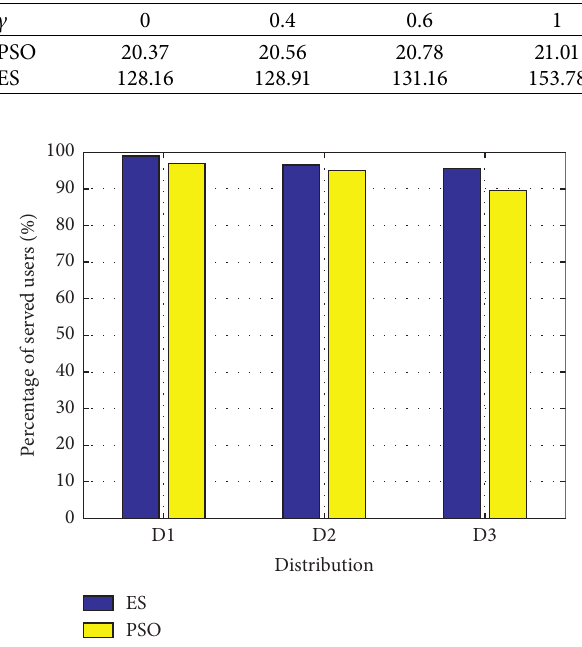
Figure 7: Robustness of the proposed